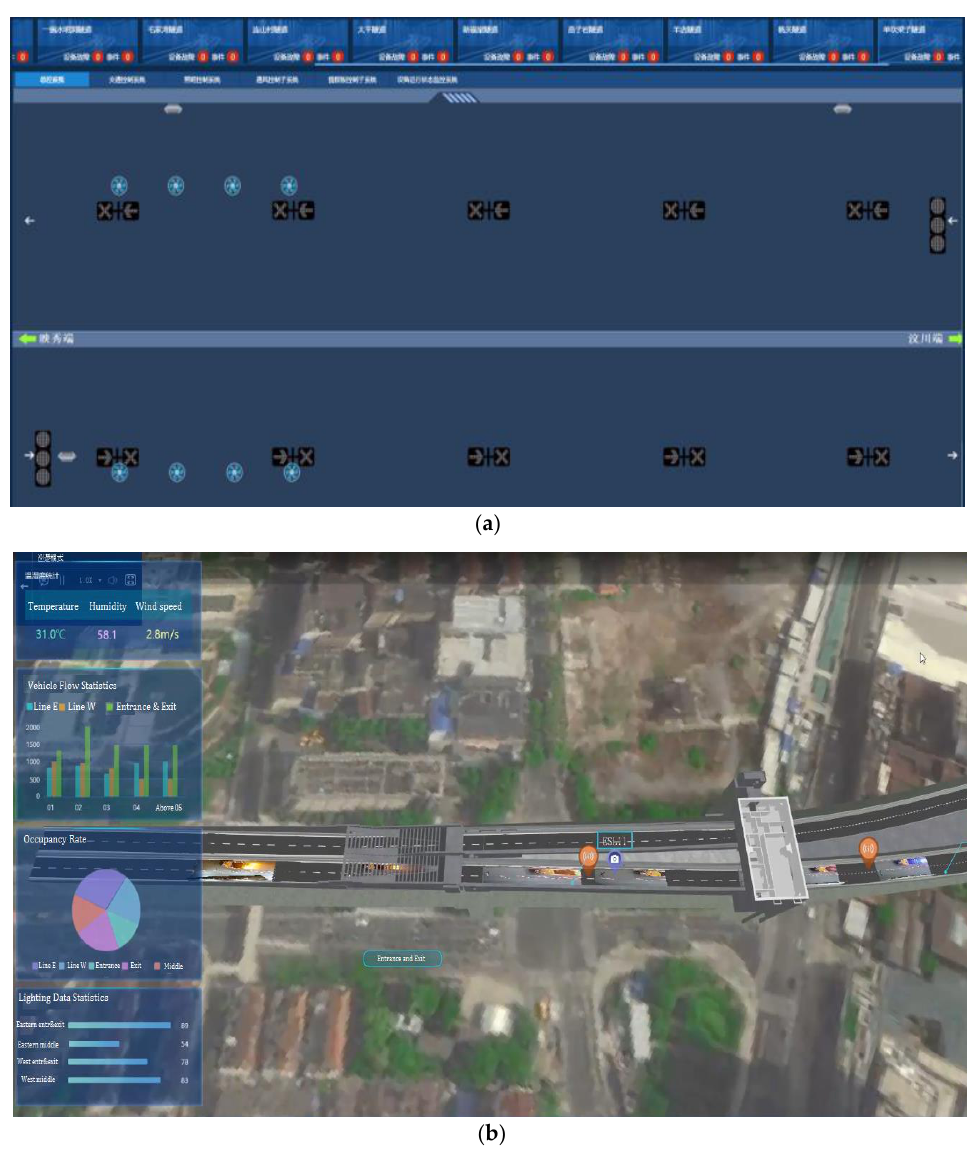
Figure 18. Comparison of tunnel service data integration before and after demonstration: ( a ) Video is separated from the professional subsystems; ( b ) video and service data convergence and en- hanced display.